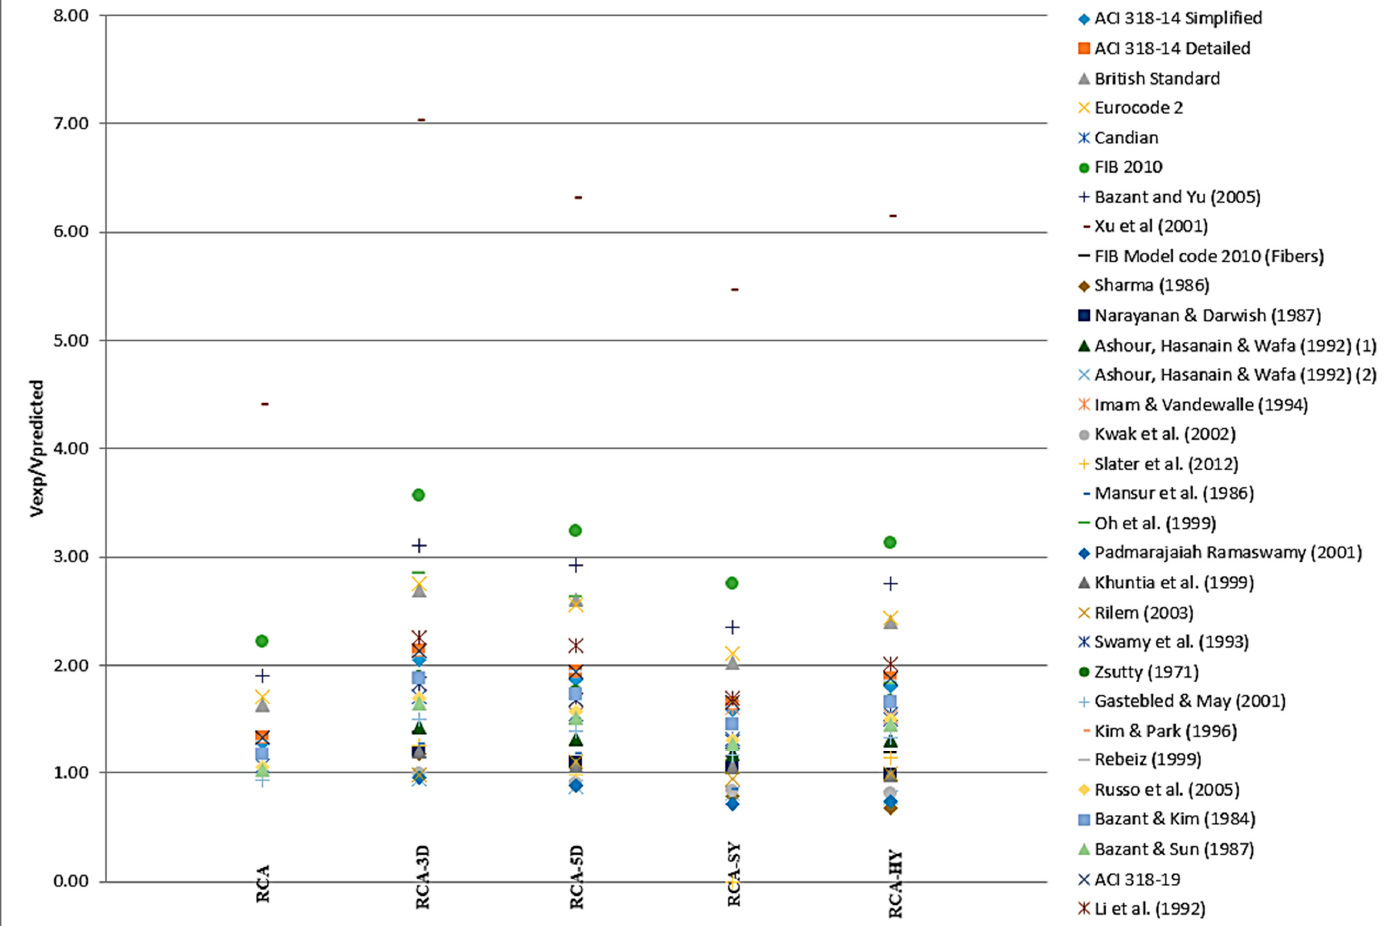
Figure 17. Summary of the Experimental Results versus Proposed Equations.